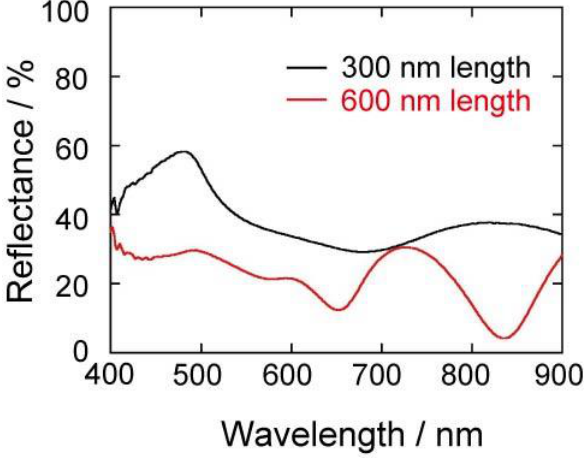
Figure 7. Visible absorption spectra of the gold nanocarpets with nanorods of 300 and 600 nm in length. The black and red curves are the spectra of the nanocarpets with 300 and 600 nm in rod length,